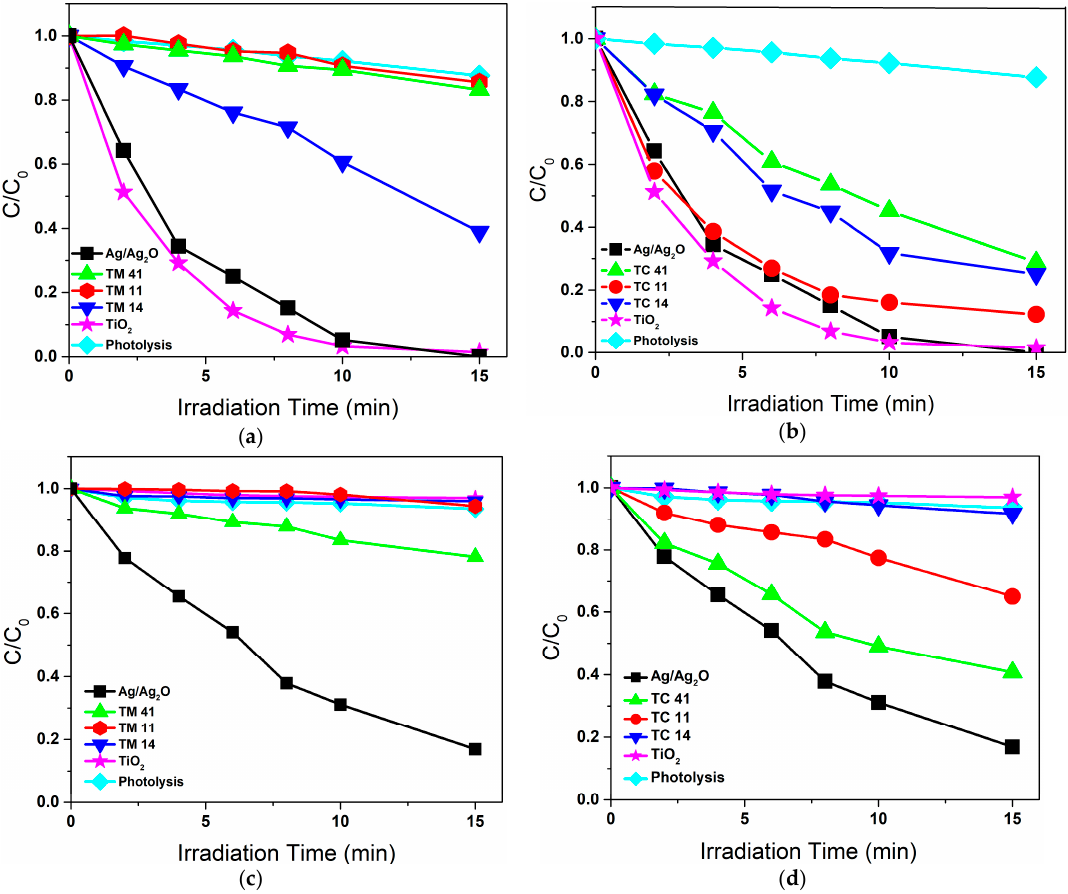
Figure 4. Bleaching of MB in the presence of Ag/Ag 2 O, TiO 2 , the TM mixtures and the TC composites under UV/vis ( a , b ) and under vis light only ( c , d ).